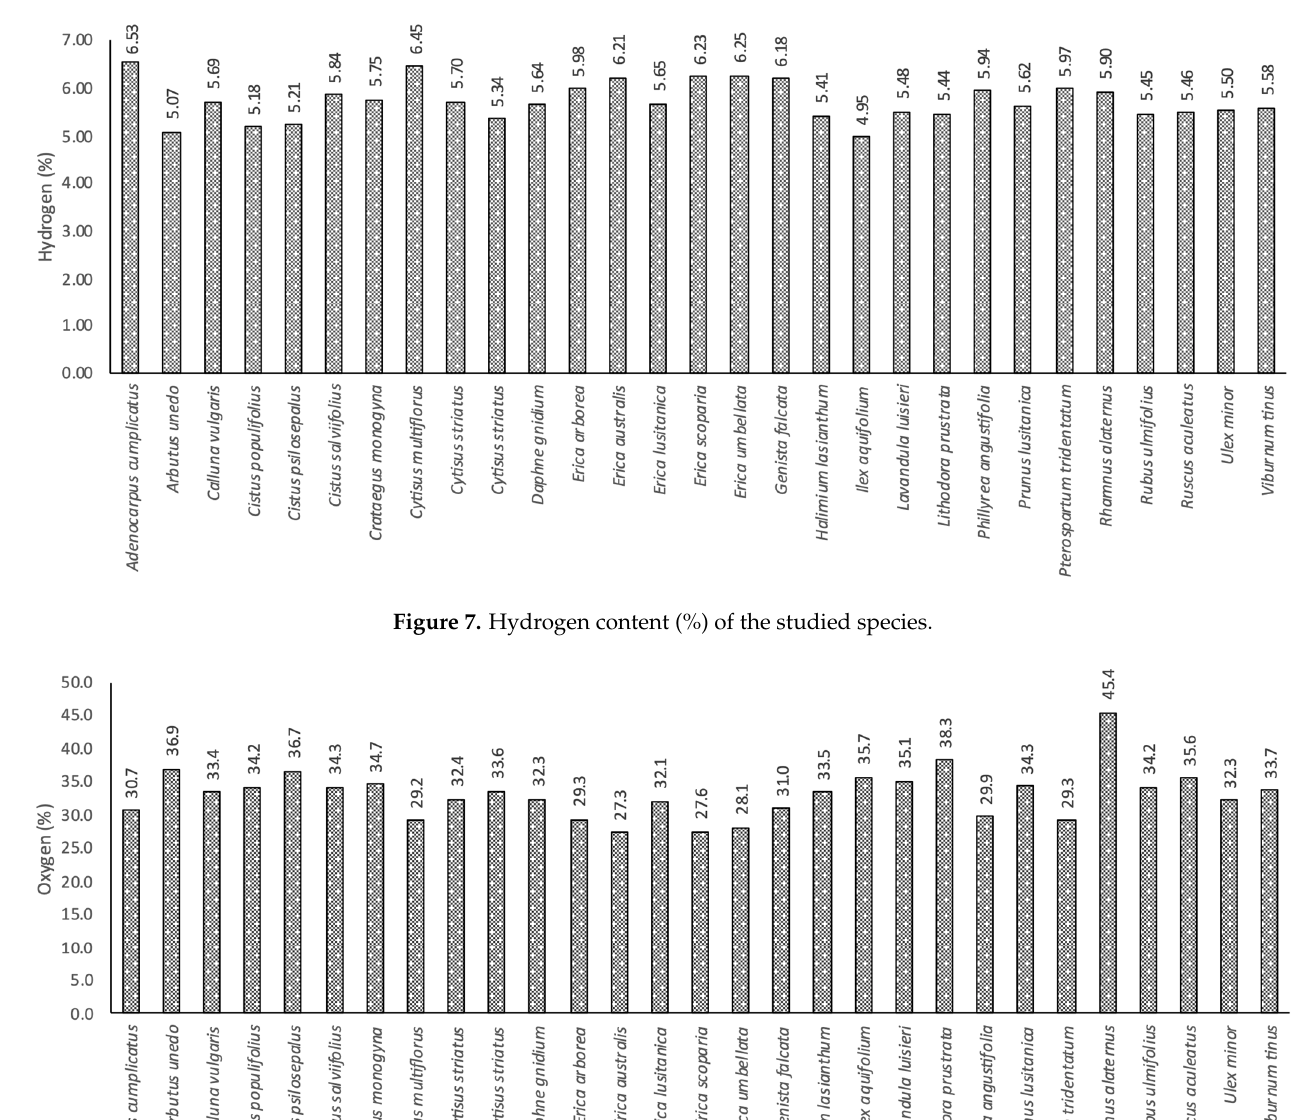
Figure 6. Carbon content (%) of the studied species.